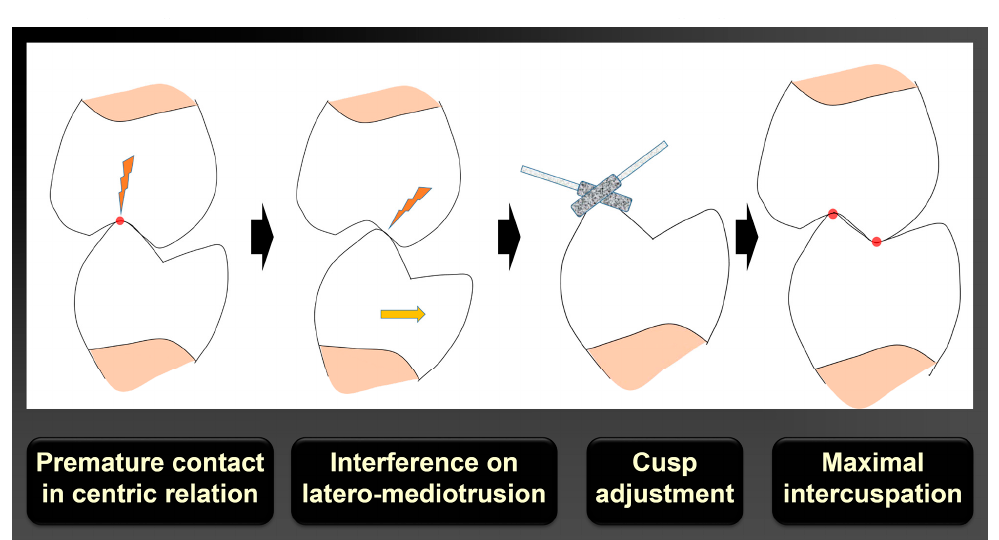
Figure 2. Two-dimensional presentation method with schematic illustrations.